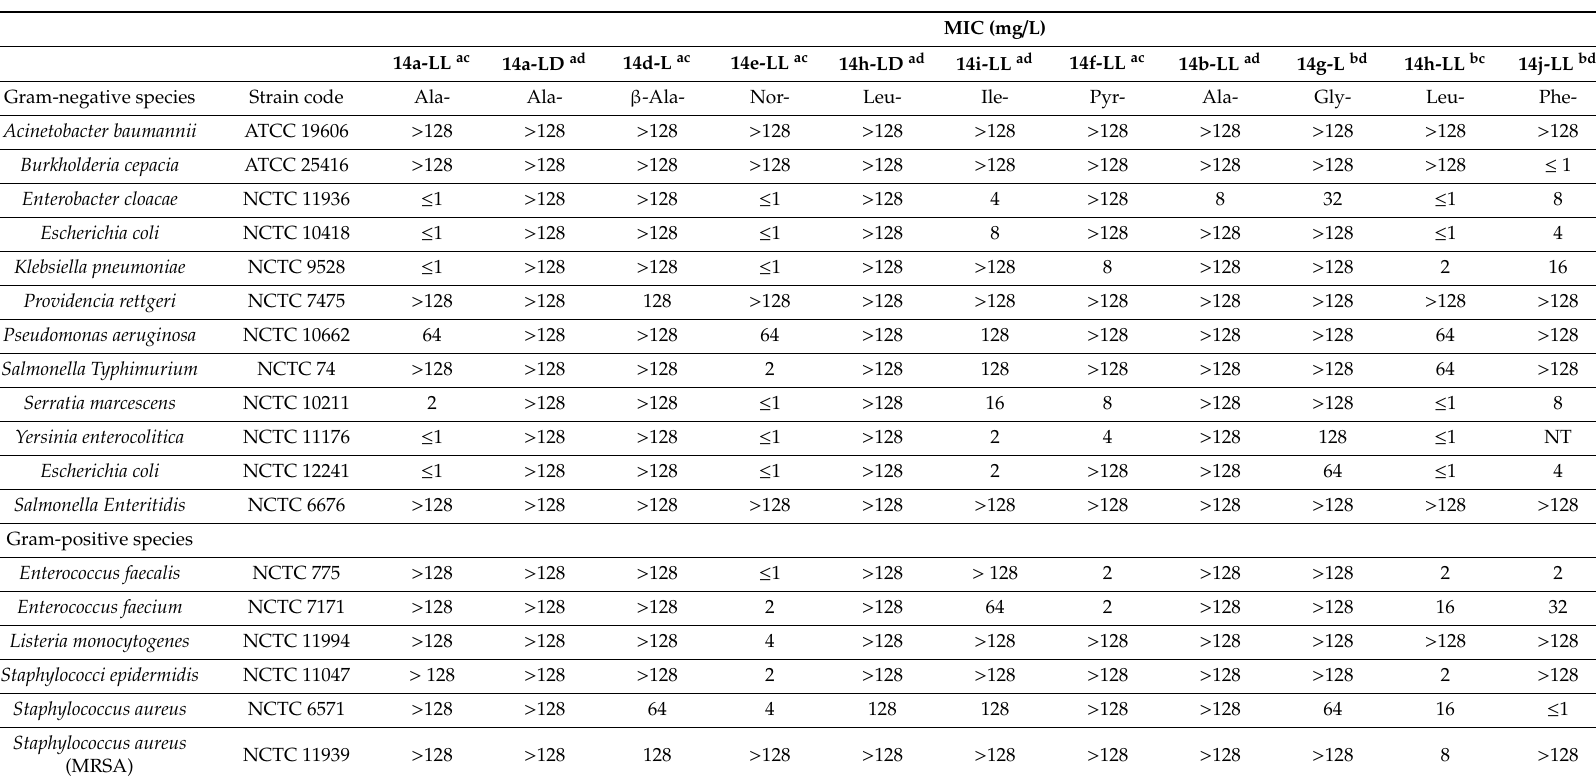
Table 2. MIC values (mg / L) of C-terminal 1-aminoethyltetrazole containing dipeptides 14a,d-j ; NCTC: National Collection of Type Cultures, Colindale, UK; ATCC: American Type Culture Collection, Manassas, United States; NT: not tested; a: inoculum 150000 CFU / spot; b: inoculum 10000 CFU / spot; c: the tested compound